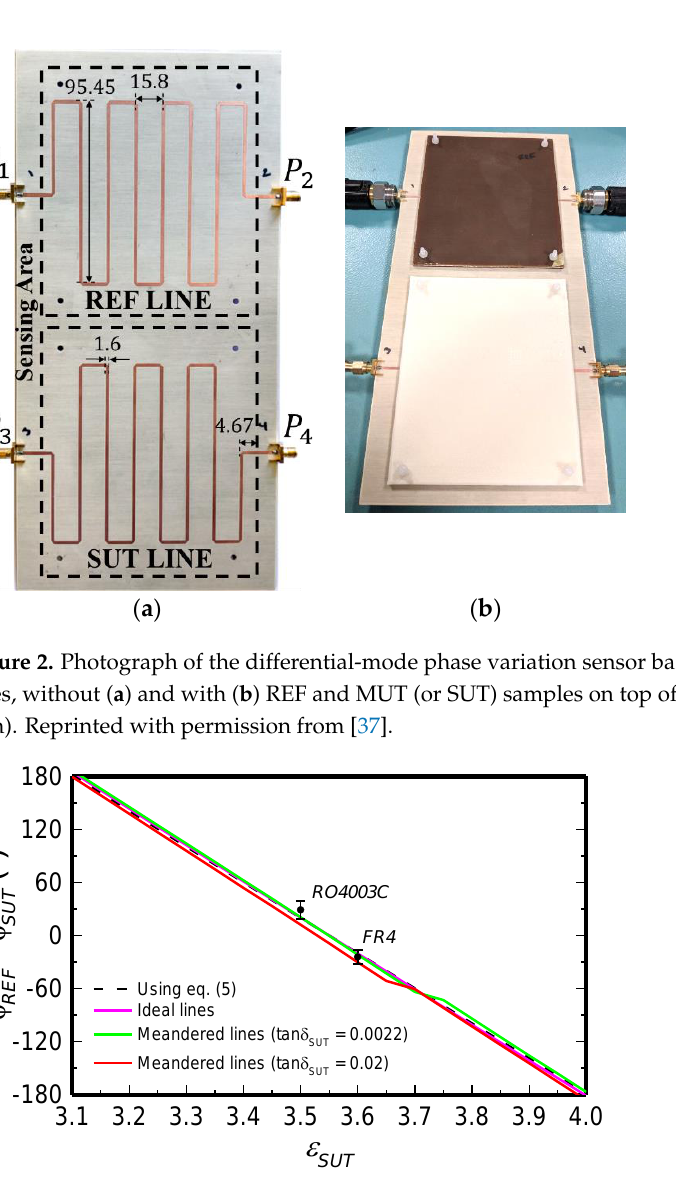
Figure 3. Simulated differential phase at f 0 = 6 GHz for the sensor of Figure 2, as a function of the dielectric constant of the MUT, parameterized by the loss tangent of the MUT. The curve given by Equation (17), or by Equation (5) in the source paper [37], is also included. The mean of the measured differential phases (with N = 3 independent measurements) for the indicated materials, as well as the error bars inferred from the standard deviation, are also included. Reprinted with permission from [37].